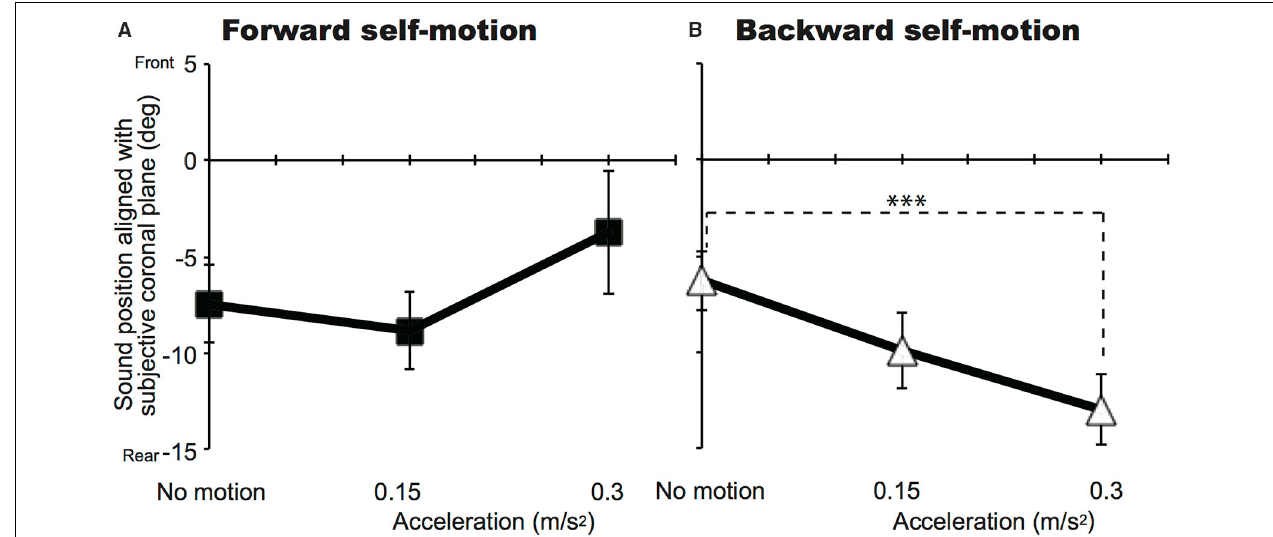
function of acceleration. The null point indicates the physical coronal plane. Error bars denote standard errors. Note that the participants experienced self-motion perception but were not physically moved. ∗∗∗ p < 0 . 005.